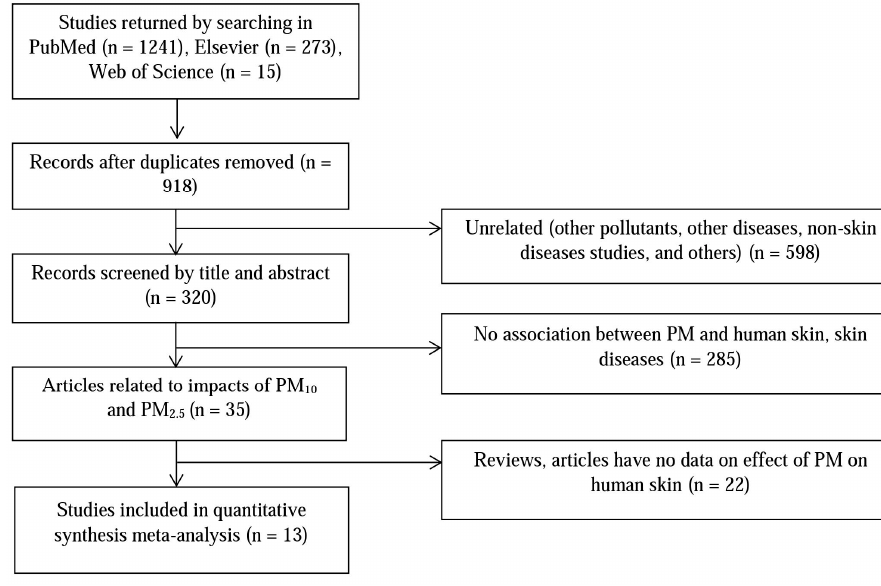
Figure 1. Systematic screening stage for literature review.